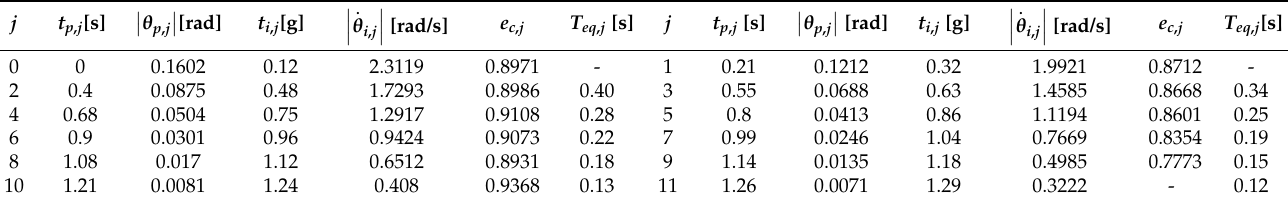
Table 10. Summary of the results of the free oscillation test block type C2.